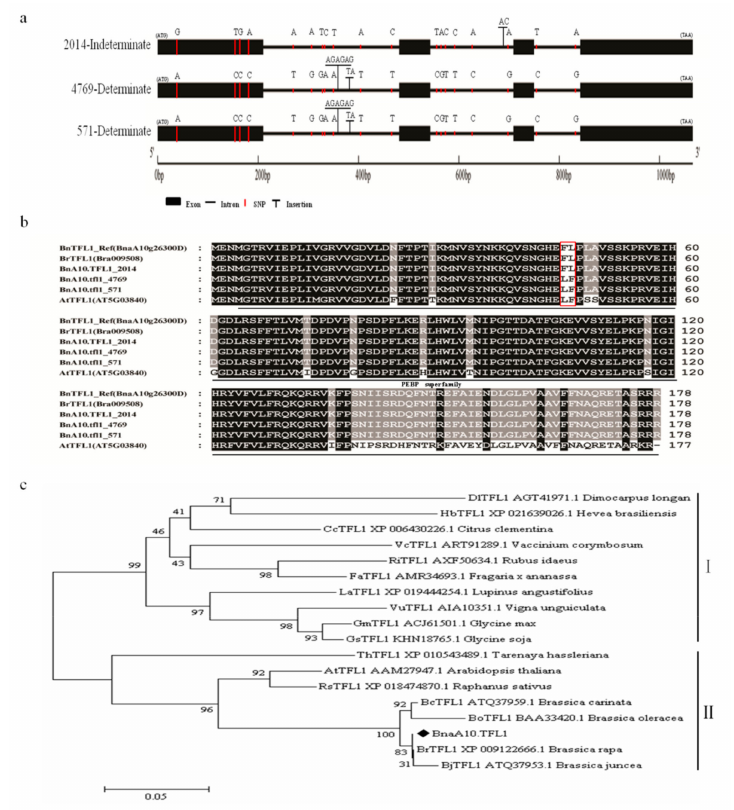
Figure 3. Sequence analysis of BnA10.TFL1 . ( a ) Gene structure and natural variations of the alleles from the indeterminate line 2014 and determinate lines 4769 / 571 of BnA10.TFL1 / BnA10.tfl1 . ( b ) Amino acid sequences of BnA10.TFL1 and BnA10.tfl1 from the indeterminate 2014 and determinate 4769 / 571 plants were aligned with those of other species, including A. thaliana AtTFL1 ( AT5G03840 ), BnTFL1_Ref ( BnaA10g26300D ) from the B. napus reference genome, and BrTFL1 ( Bra009508 ) from the B. rapa reference genome. The black line indicates the Phosphatidylethanolamine-binding protein (PEBP) domain. The red border indicates the position of amino acid di ff erence between indeterminate 2014 and determinate 4769 (571). ( c ) Phylogenetic tree of TFL1 homologous proteins. These proteins are marked with their gene names and NCBI accession numbers. The black square indicates BnA10.TFL1, I and II show the two separate